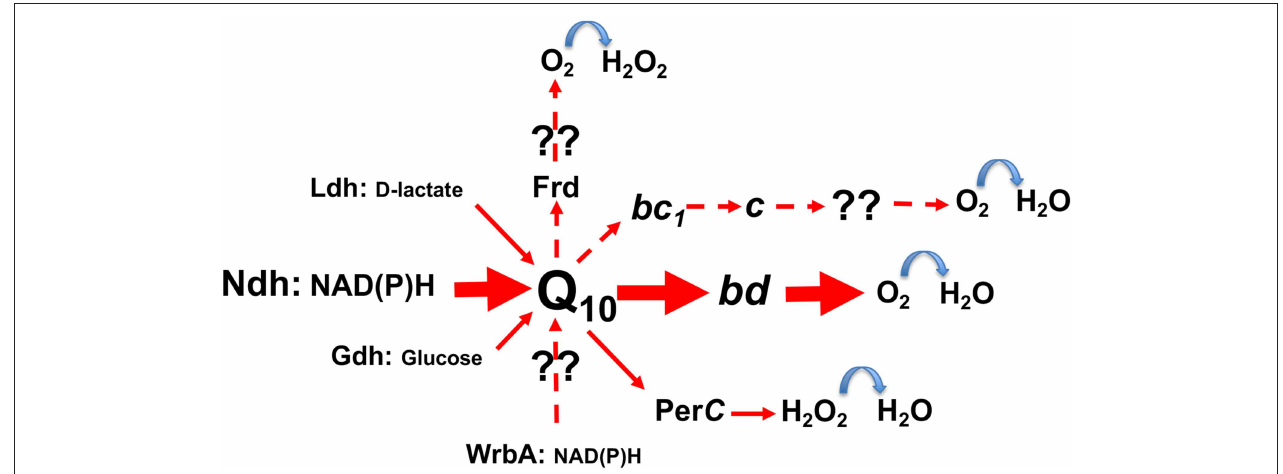
FIGURE 2 | The scheme of electron transport pathways in Zymomonas mobilis respiratory chain. Hypothetical pathways are shown with dashed arrows. Frd, putative fumarate reductase; WrbA, putative type IV NAD(P)H:quinone oxidoreductase; for other abbreviations see text.